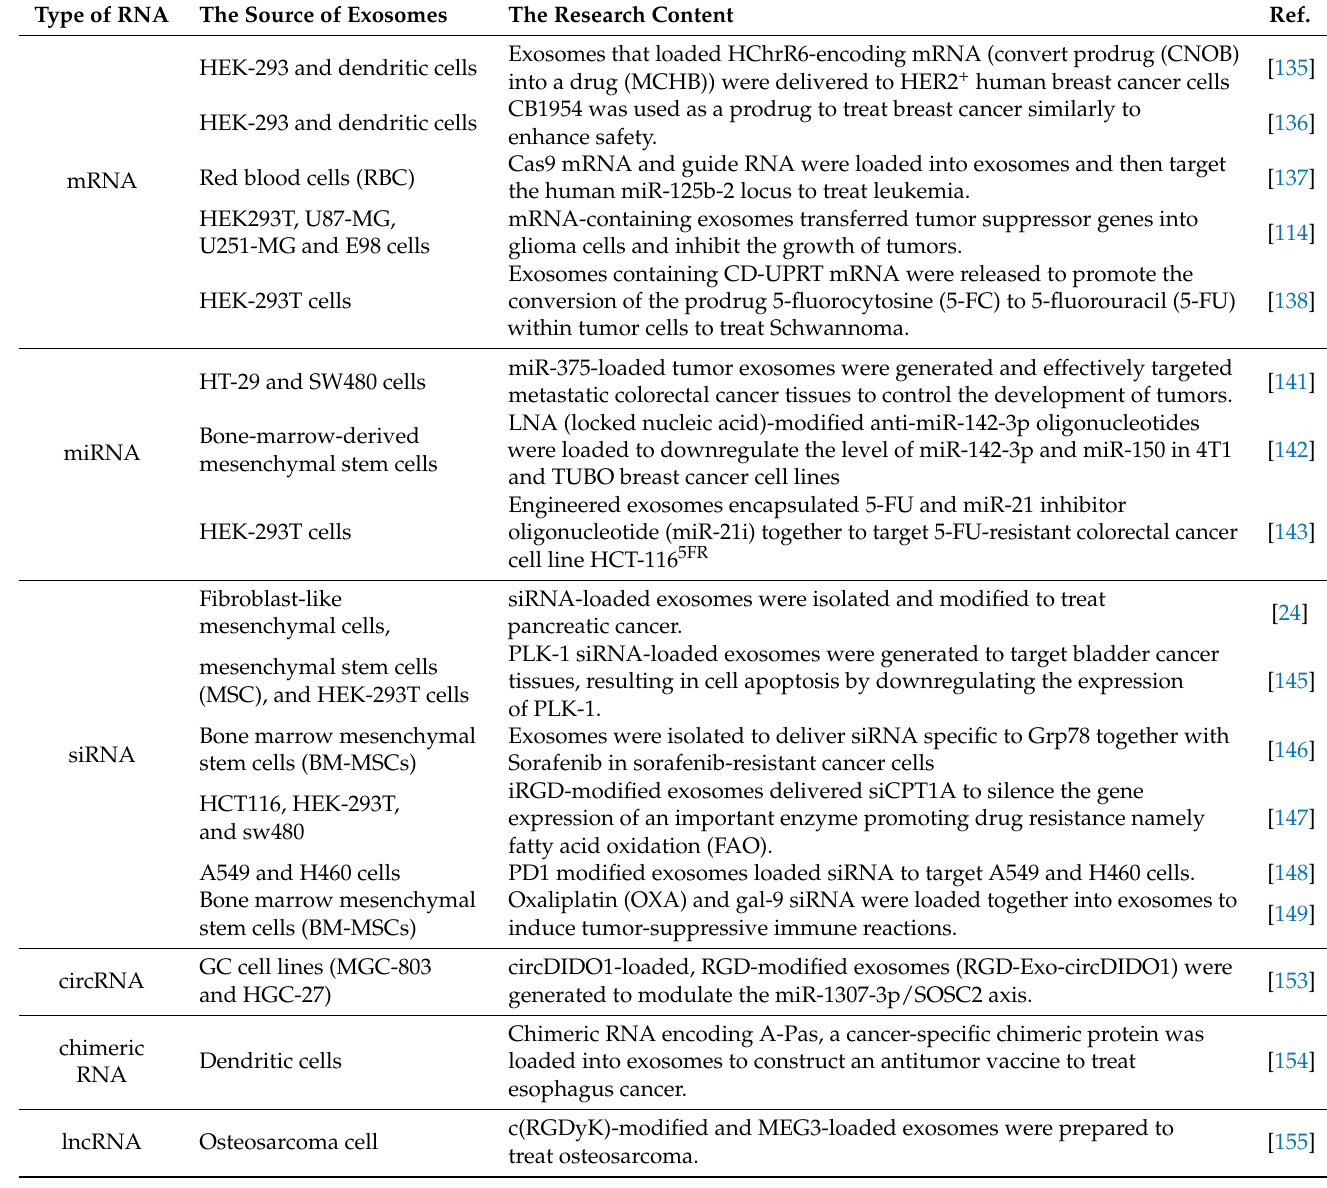
Table 3. Application of RNA-loaded exosomes in cancer